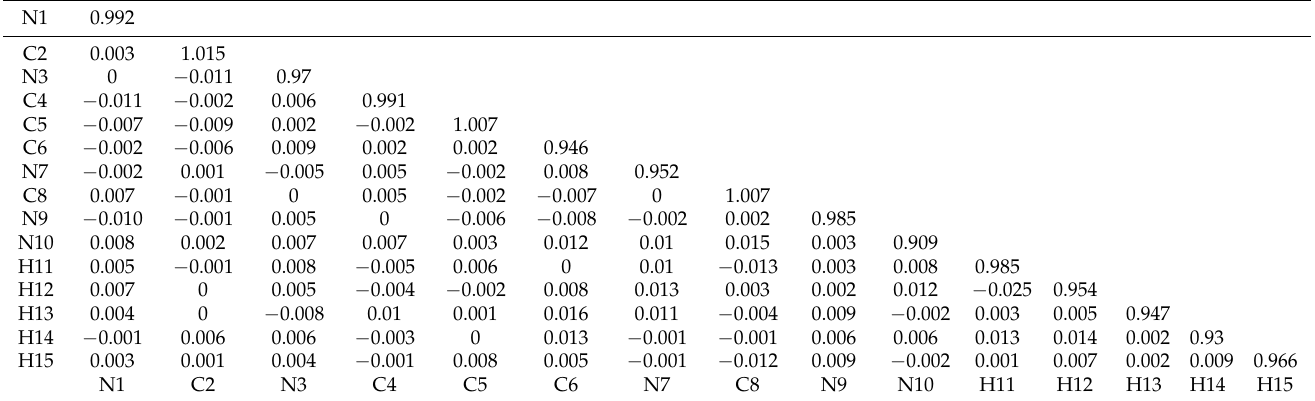
Table 3. B3LYP/6-31G* Cartesian scale factors (matrix B ) for adenine.